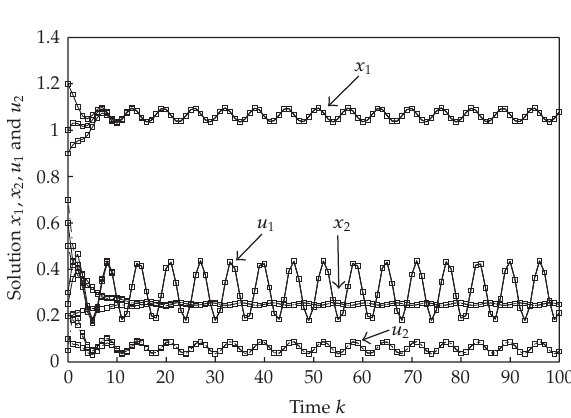
Figure 2: Dynamics behaviors of system (cid:3) 4.1 (cid:4) with initial values (cid:3) x 1 (cid:3) 0 (cid:4) ,x 2 (cid:3) 0 (cid:4) ,u 1 (cid:3) 0 (cid:4) ,u 2 (cid:3) 0 (cid:4)(cid:4) (cid:5) (cid:3) 0.9, 0.7, 0.6, 0.05 (cid:4) , (cid:3) 1.2, 0.5, 0.3, 0.2 (cid:4) , and (cid:3) 1, 0.2, 0.25, 0.1 (cid:4)